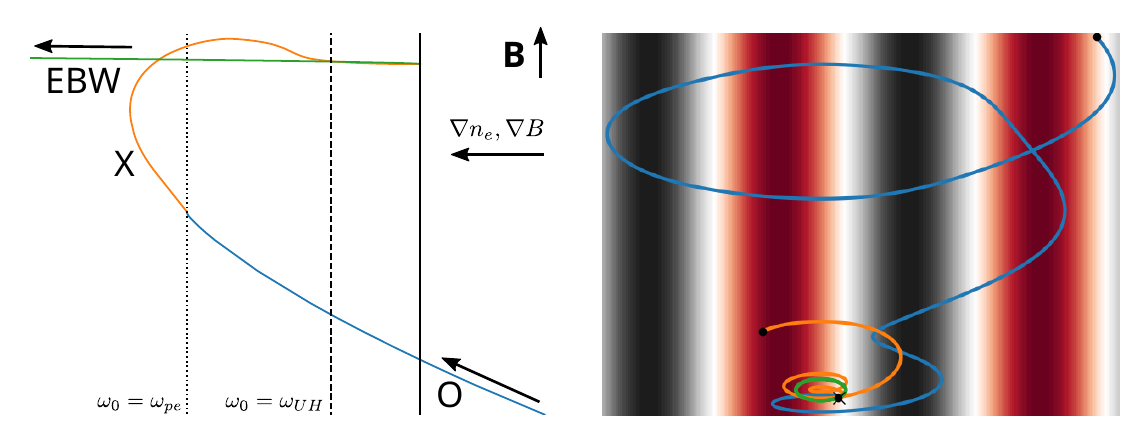
Figure 1: Figures illustrating basic concepts of the theory